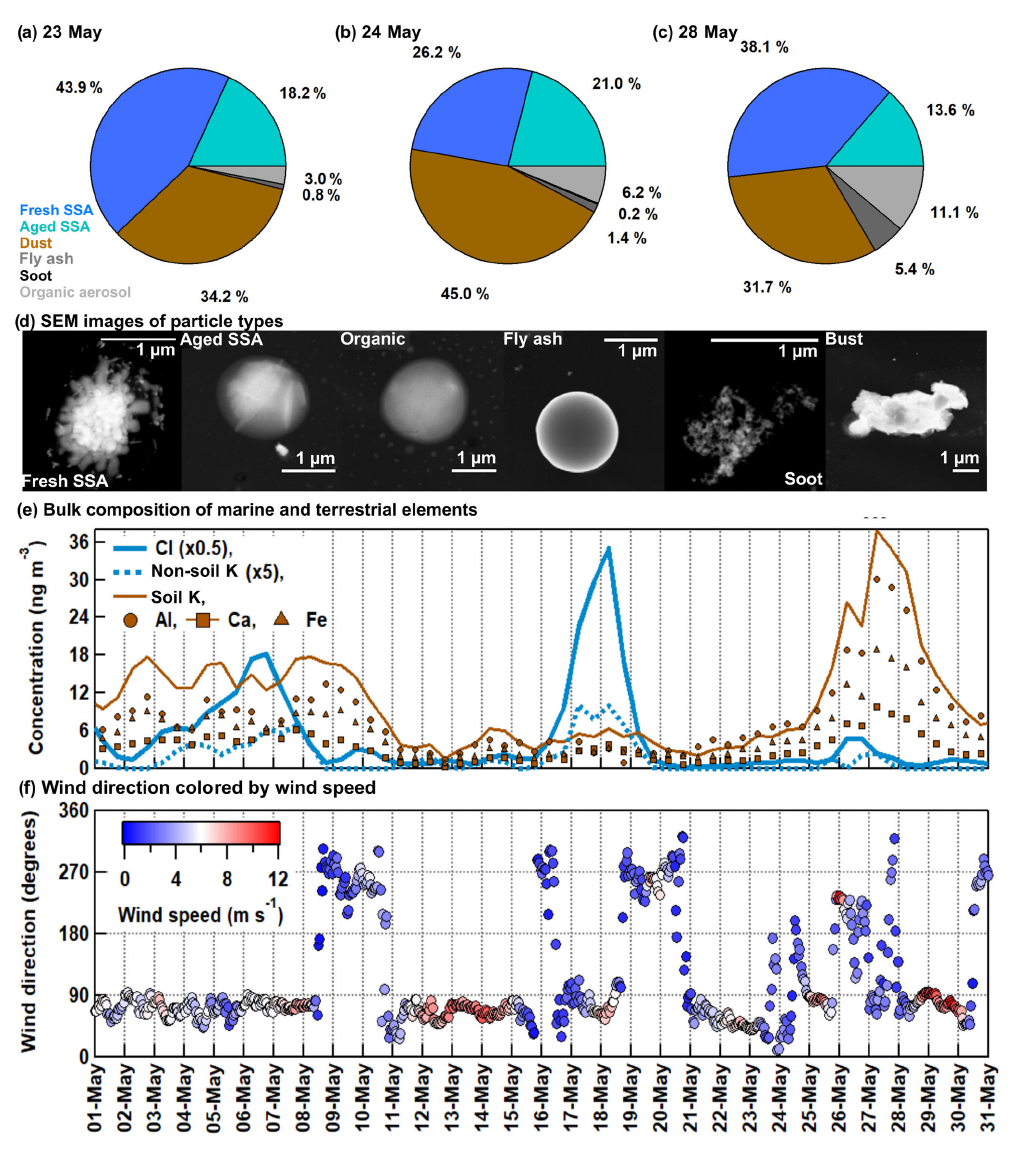
Figure 7. Summary of results from single-particle and bulk compositional measurements during the late May time period. Relative number fractions of CCSEM-EDX single-particle types for samples (>1.15µm) for (a) 23 May (1156 particles), (b) 24 May (918 particles), and (c) 28 May (723 particles). SSA represents sea spray aerosol. Examples of SEM images of the particle types classified are shown in (d) , with the length of the bar scaled to 1µm. S-XRF results for May for elements in the 0.75 to 5.0µm size range associated with either marine (Cl and non-soil K) or terrestrial (soil K, Al, Ca, and Fe) sources are shown in (e) . Cl and non-soil K concentrations are provided as × 0.5 and × 5 their concentrations, respectively, to show on the same axis. (f) Wind direction is also shown, colored by wind speed. For both CCSEM-EDX and S-XRF classifications, shades of blue and brown represent marine and terrestrial sources,